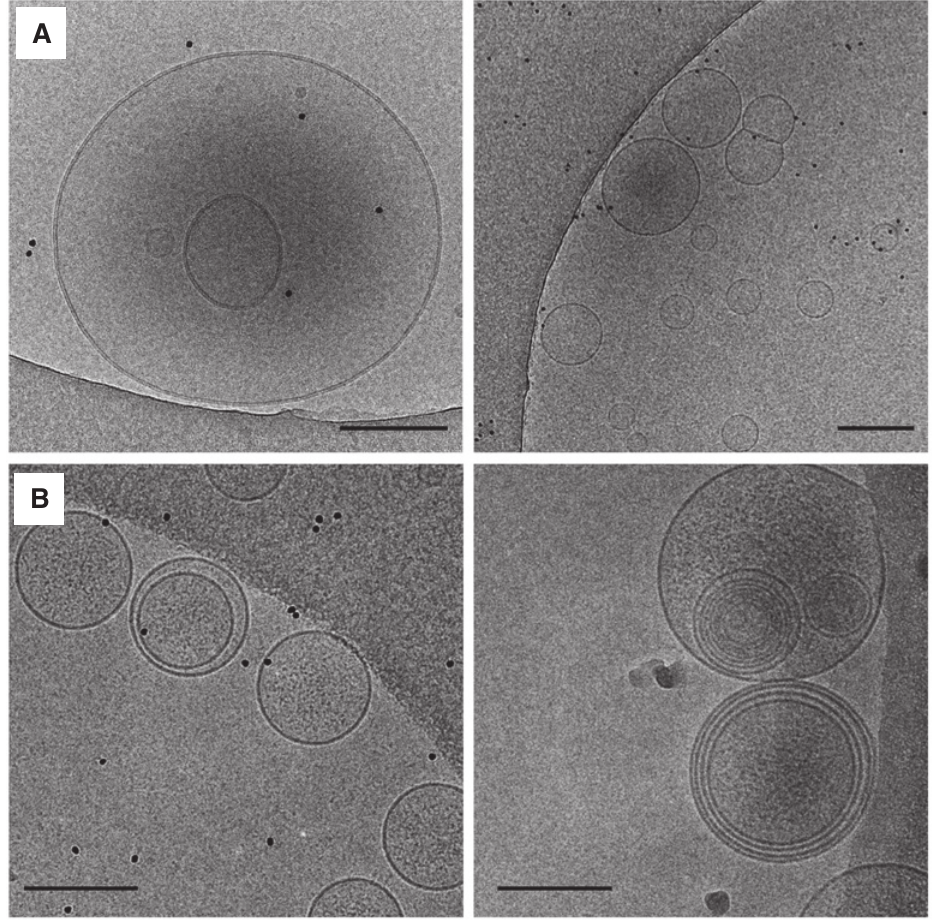
Figure 6: Encapsulation of gold nanoparticles (GNPs) investigated by cryo-EM. E. coli polar lipid extract liposomes were formed in 20 mm Tris-HCl pH 7.6, 1 mm EDTA buffer containing the indicated additional material and dispersed in the same buffer without it. (A) GNPs, diluted 1 : 60 in the same buffer. The distribution of GNPs in the background and apparently in the lumen of the liposomes is the same